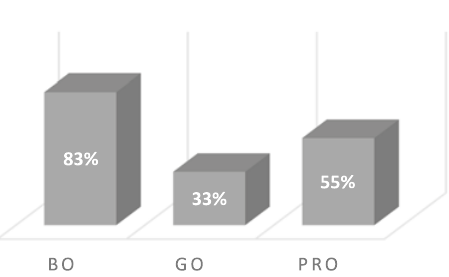
fig. 4. The percentage of participant recognising “Conflicting multiple objectives” as a challenge